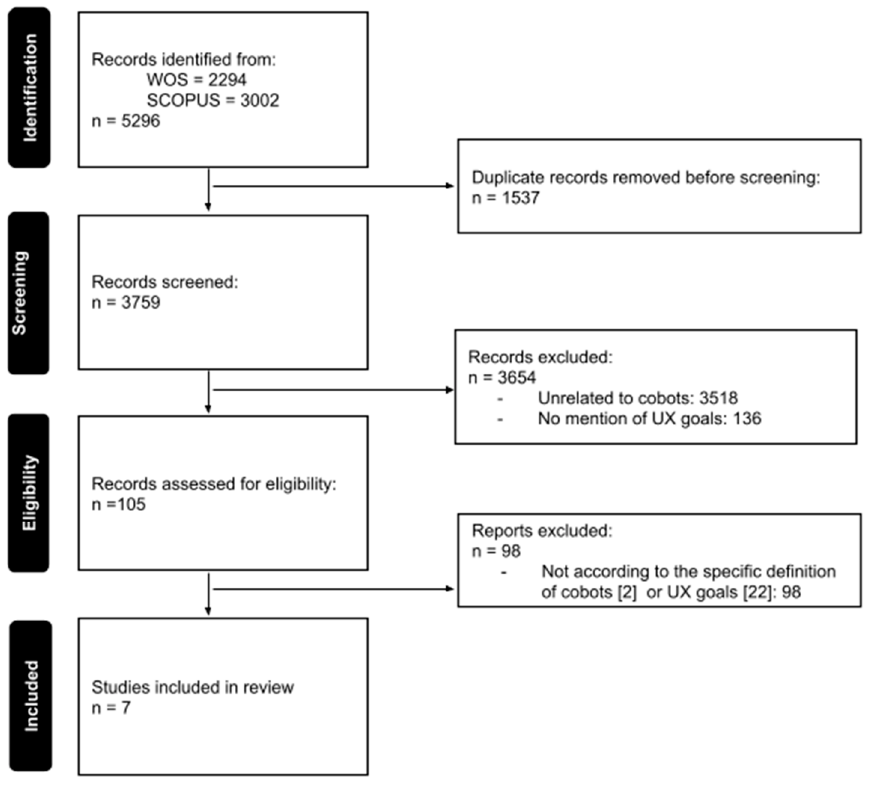
Figure 1. PRISMA Statement flow diagram [2,22].